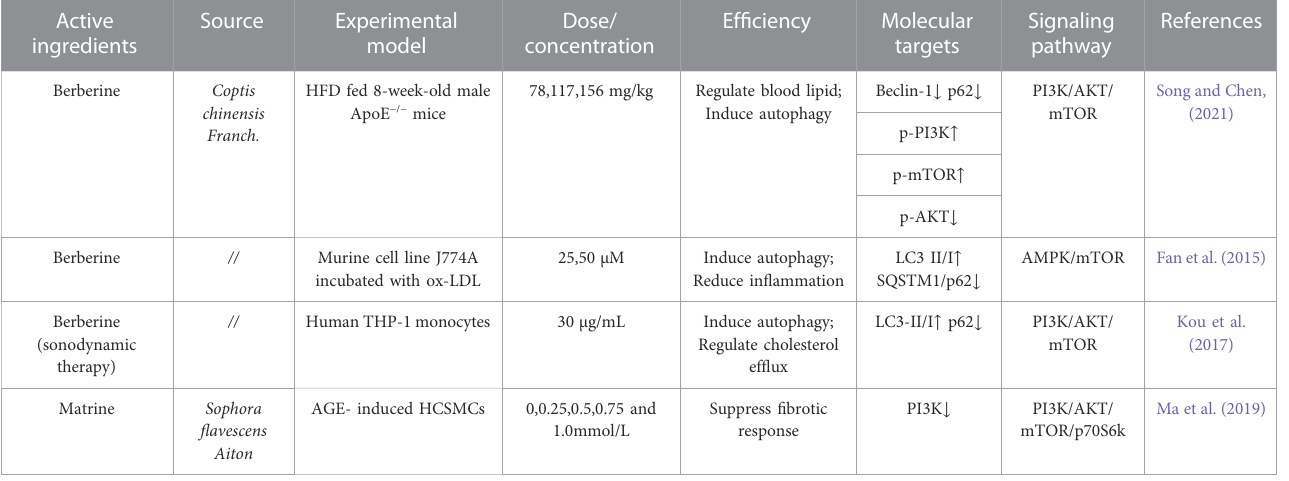
TABLE 2 Summary of effects of natural alkaloids on different AS models. Active